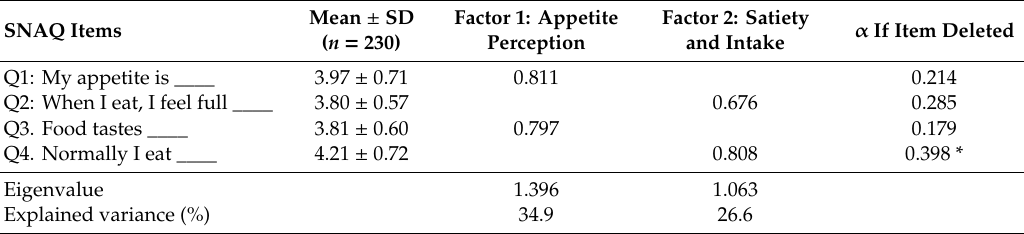
Table 3. Factor Structure and Internal Consistency of SNAQ.